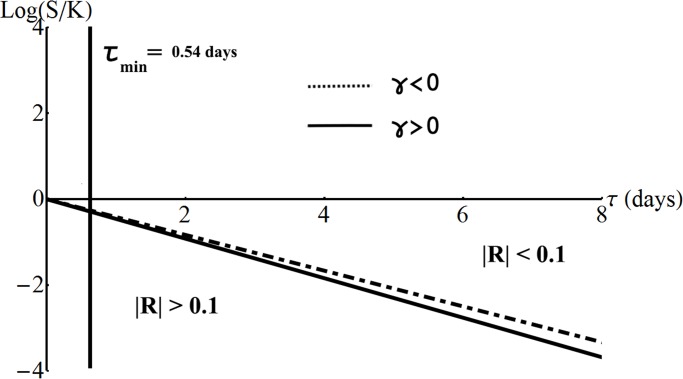
ORP replication accuracy region.Approximation for the accuracy region ∣R∣ < R
c in the (M, τ)–plane for σ = 0.2 years−1/2, γ = ±0.01 years−1/3, r = 0.02 years−1, R
c = 0.1 and η
c = 6.